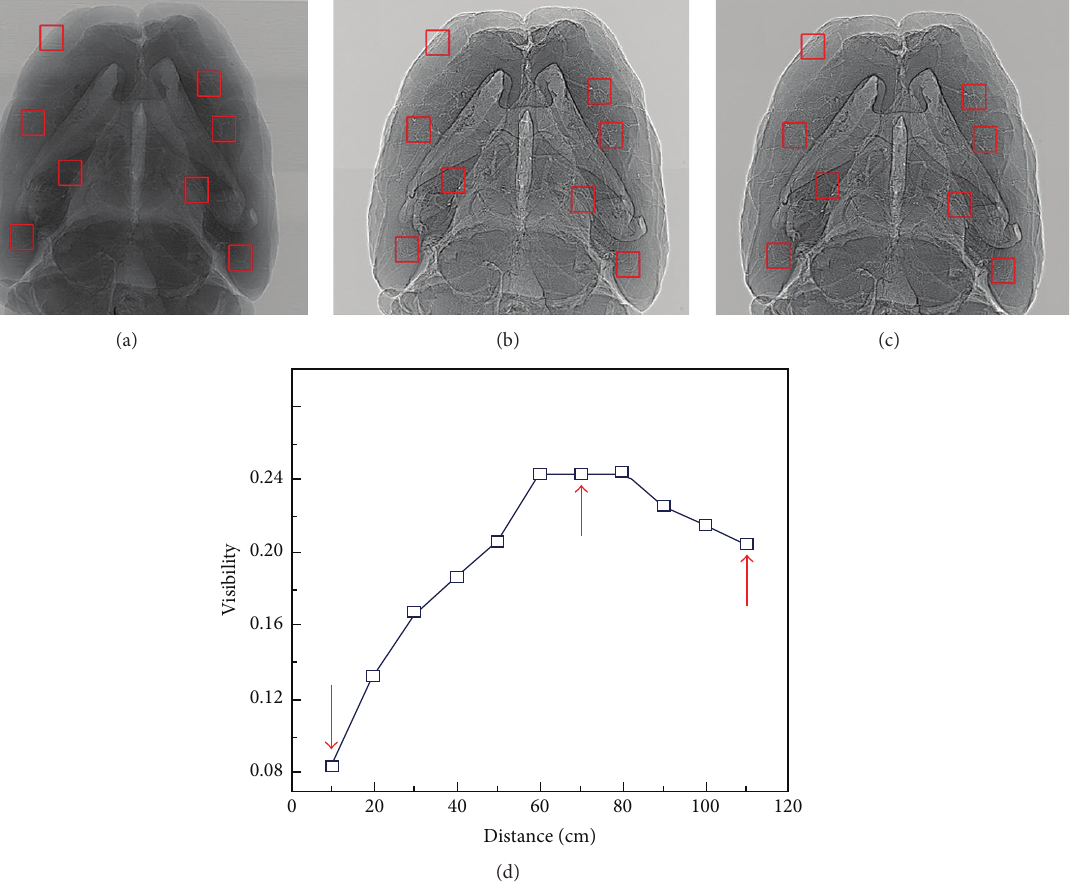
Figure 2: Optimization of SRXPCT: corrected phase images acquired with different sample-to-detector distances ((a) 10 cm, (b) 70 cm, and (c) 110cm). (d) The averaged visibilities of all boxed areas in (a)–(c) at different sample-to-detector distances.